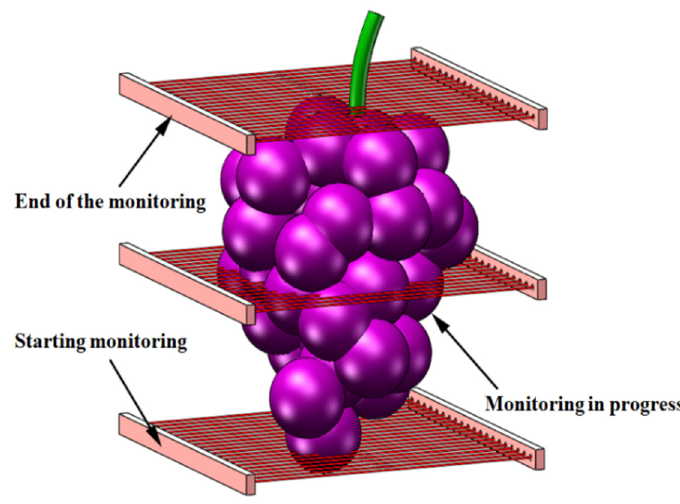
Figure 8. Diagram of picking location strategy.